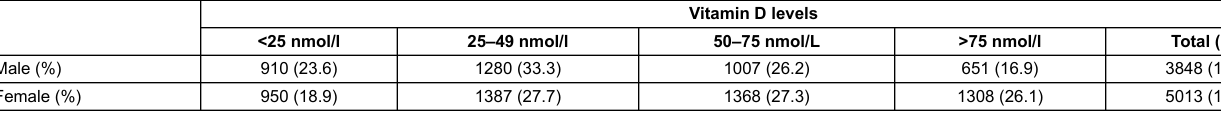
Table 2: Distribution of vitamin D concentrations by